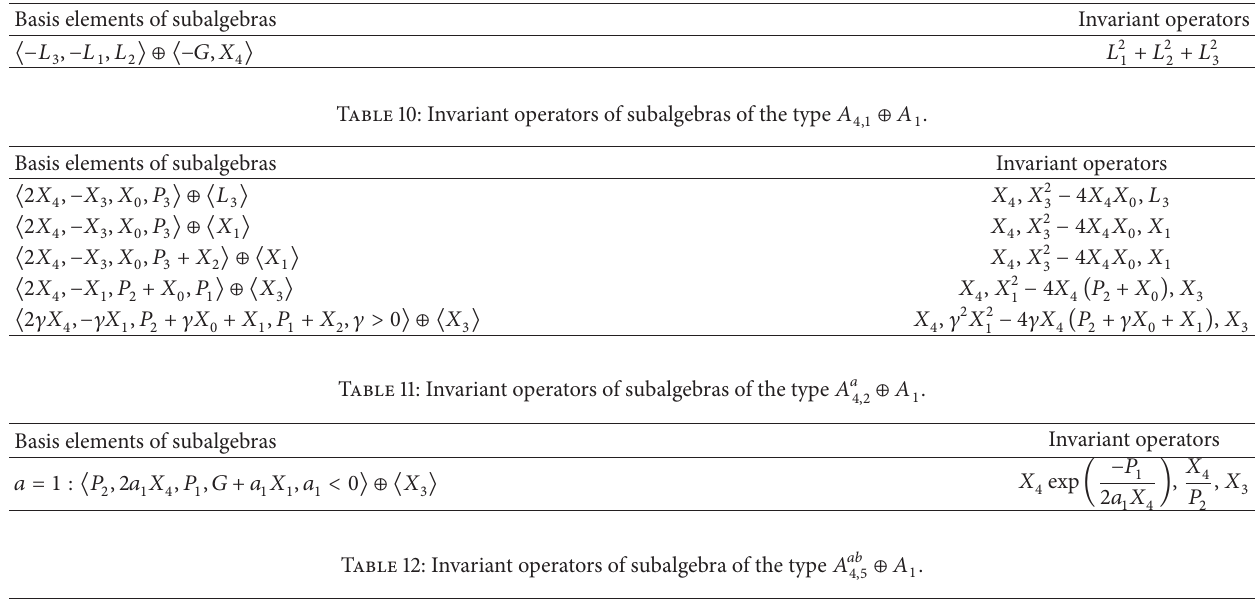
Table 9: Invariant operator of subalgebra of the type 𝐴 3,9 ⊕ 𝐴 2 .